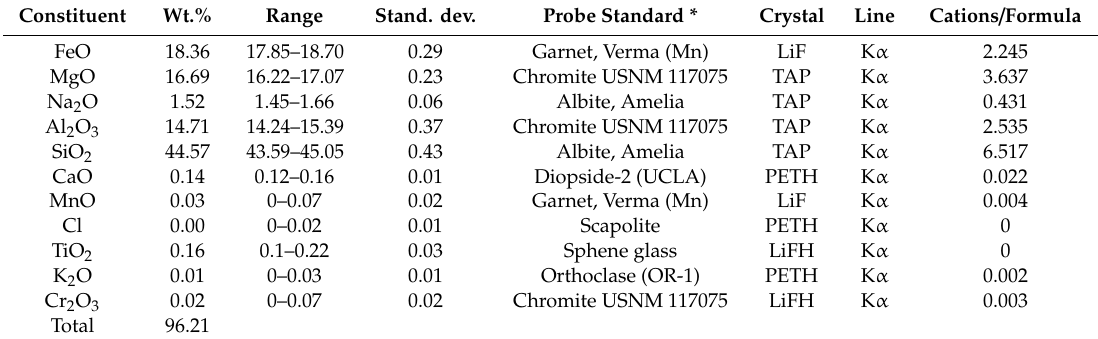
Table 1. Results from microprobe analyses.